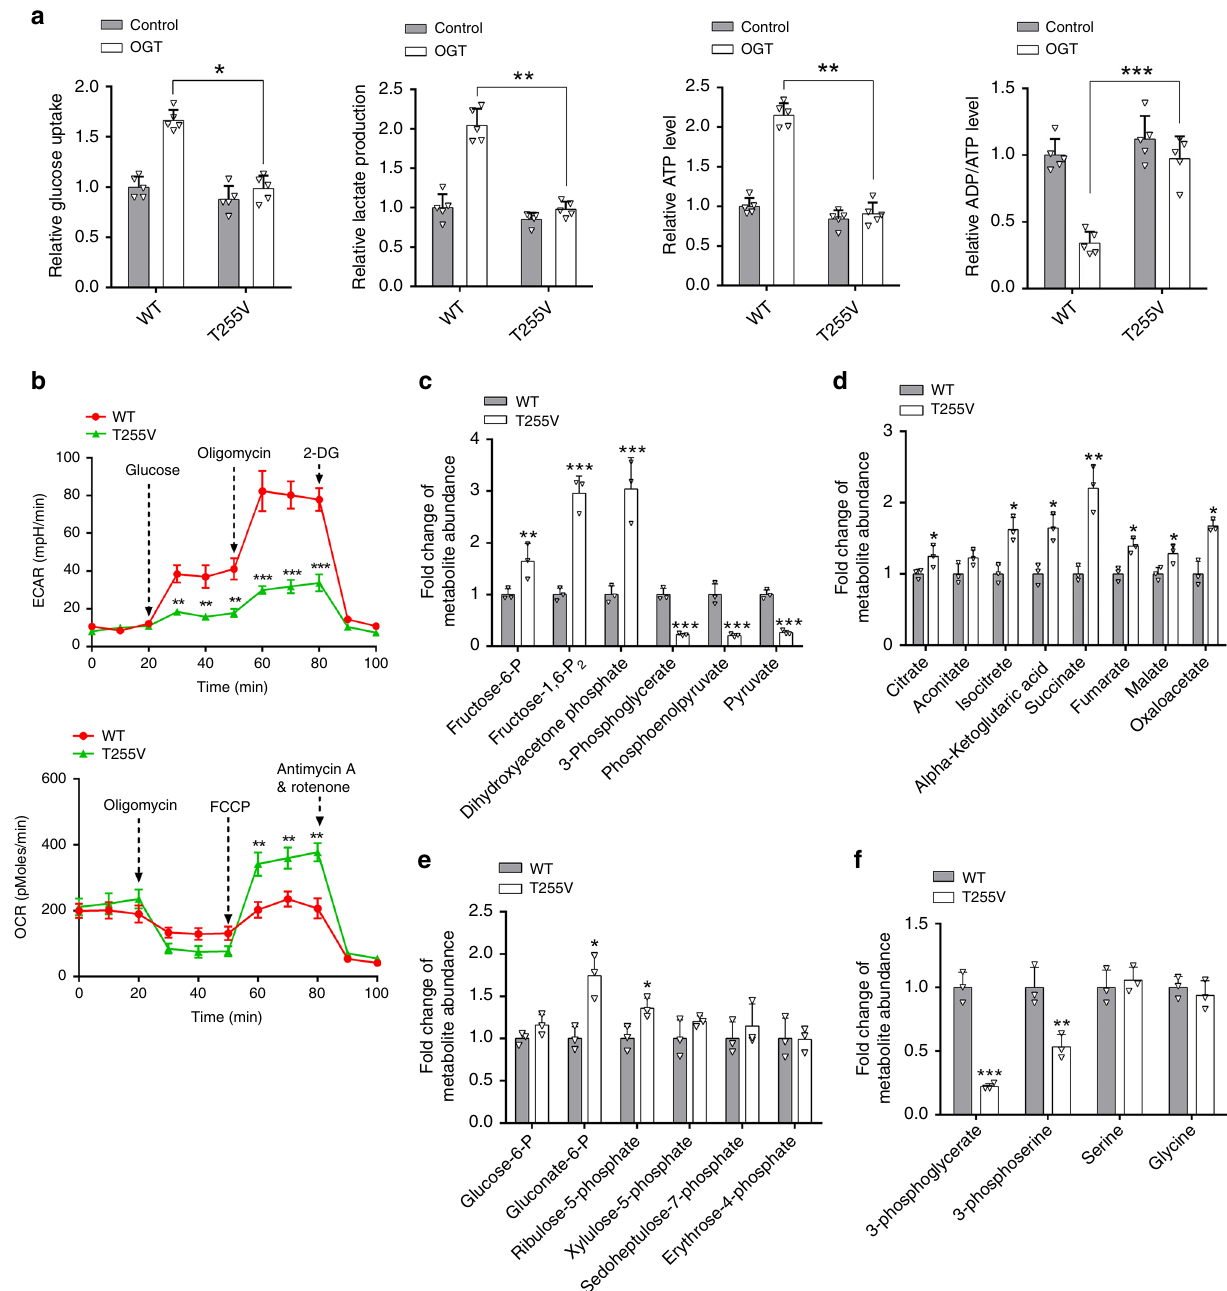
Fig. 7 T255 O-GlcNAcylation of PGK1 regulates glucose metabolism in cells. a Comparison of glucose uptake, lactate production, ATP levels, and the total energy charge (ADP/ATP ratio) in PGK1 WT or T255V rescue HT-29 cells in the presence or absence of OGT overexpression. b The extracellular acidi fi cation rate (ECAR) and oxygen consumption rate (OCR) in PGK1 WT or T255V rescue HT-29 cells in the presence of OGT